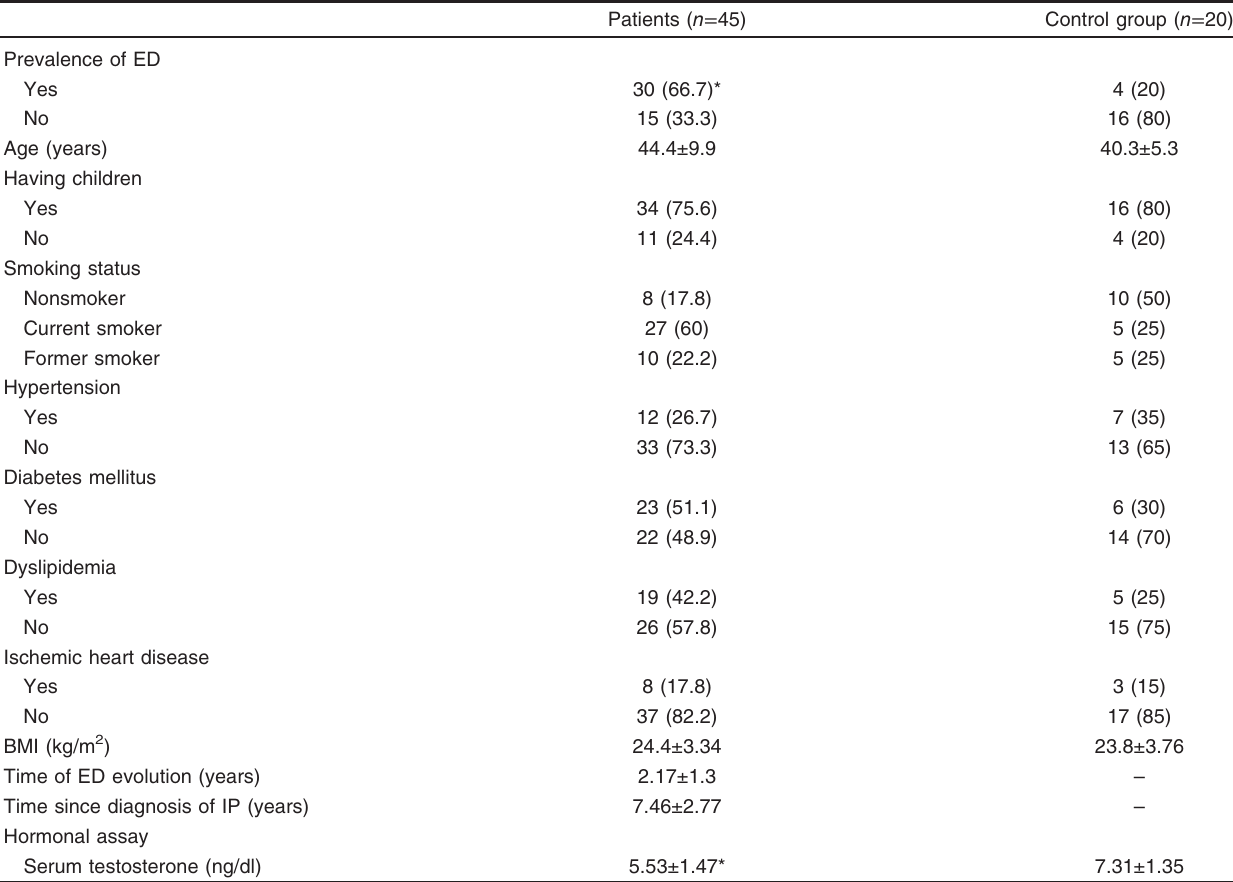
Table 1 Sociodemographic characteristics of the studied patients with idiopathic interstitial pneumonias ( n = 45)